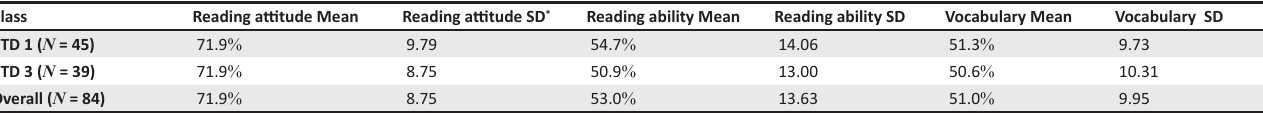
TABLE 4: Reading attitudes, Reading ability and Vocabulary knowledge. Class